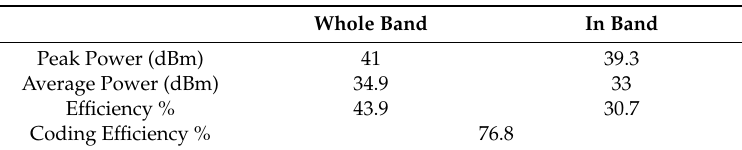
Table 4. Performances for 2.1 GHz frequency.